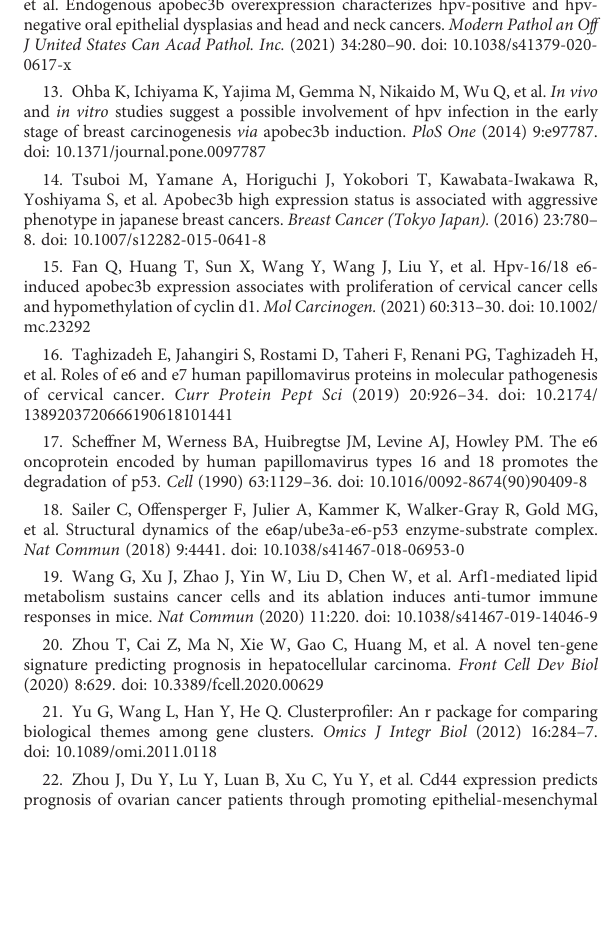
SUPPLEMENTARY FIGURE 1 (A) The relationship between APOBEC3B and tumor stemness. (B) Venn diagram of 39 common upregulated genes and 1 common downregulated gene between TCGA and GSE26511 (C) Commonly upregulated genes Metascape analysis. (D) Expression level of A3B in different cell lines. (E) Cellviability assayofHeLa, HelaNCsiRNA,HeLa A3B siRNA1,and HeLa A3B siRNA2. * p < 0.05, ** p < 0.01, *** p < 0.001, **** p <